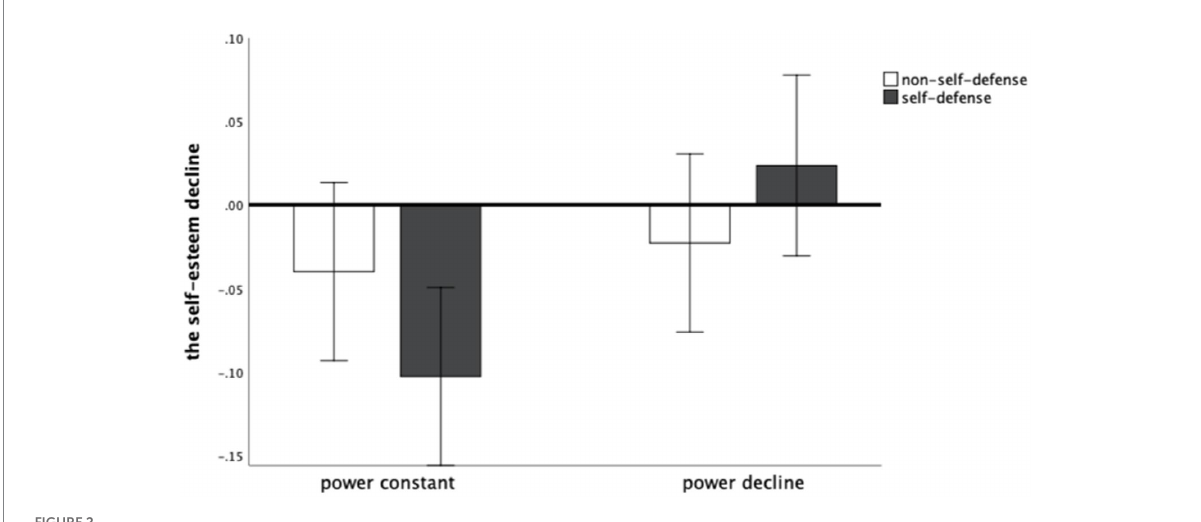
FIGURE 2 The self-esteem decline of different groups of Study